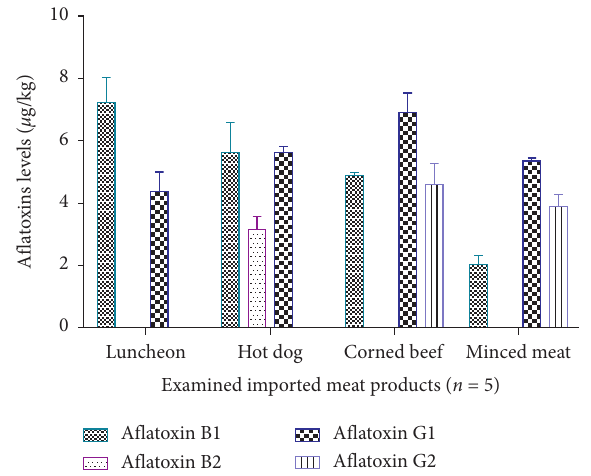
Figure 4: Aflatoxin B1, B2, G1, and G2 levels ( µ g/kg) in the ex- amined imported meat